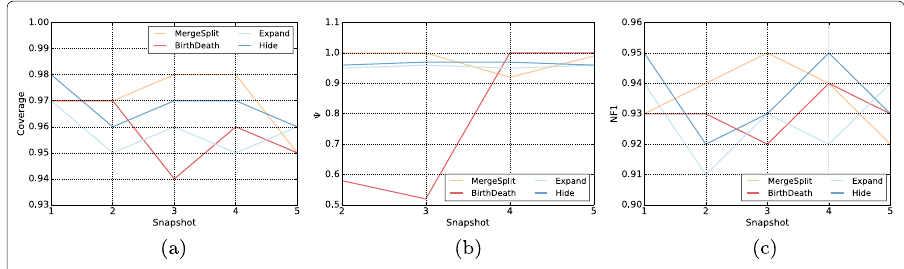
Fig. 5 Greene Benchmarks. a Community coverage per snapshot and graph sequence; b Percentage of communities matched per snapshots and graph sequence; c NF1 score per snapshot and graph